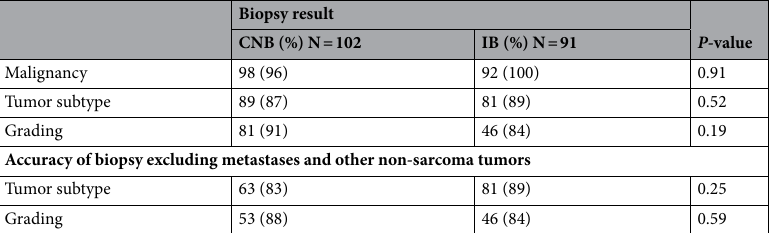
Table 2. Analysis of all patients (N = 193) reporting the accuracy of incisional and core needle biopsies with regards to diagnosis of malignancy and accuracy in diagnosing entity and grading. Accuracy is defined as agreement between pathology results on biopsy tissue and on the surgical resection specimen. Grading was diagnosed in 89 CNB and 55 incisional biopsy cases. Since the CNB group included 26 cases of non-sarcoma tumors, the accuracy of biopsies was separately calculated excluding these tumors. CNB core needle biopsy; IB incisional